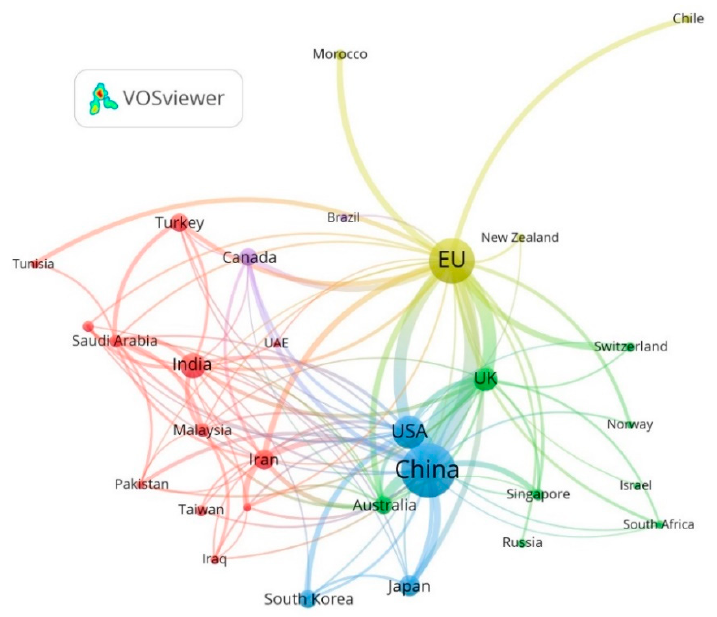
Figure 9. The country-specific co-authorship interaction-collaboration as seen within the top 20 collaboration countries.